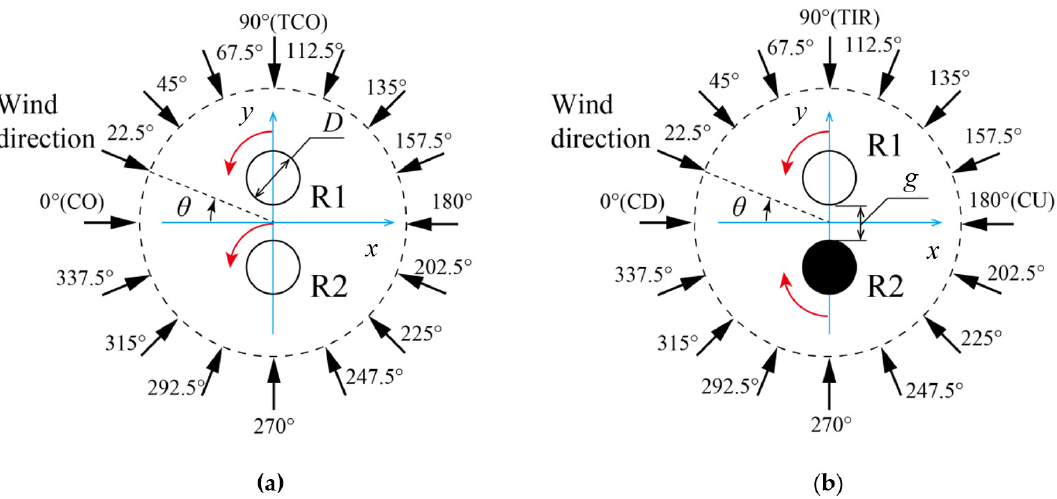
Figure 3. Definition of 16-wind-direction configurations in a closely spaced VAWT pair: ( a ) co-rotation (CO); ( b ) inverse ‐ rotation (IR).